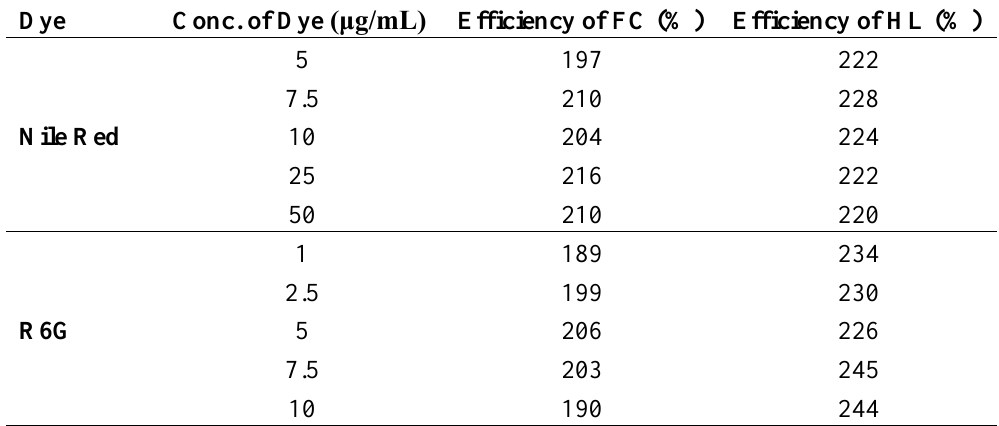
Table 2. Summary of efficiency of proposed lens for Nile Red and R6G (FC: Fluorescence collecting lens; HL: Hybrid